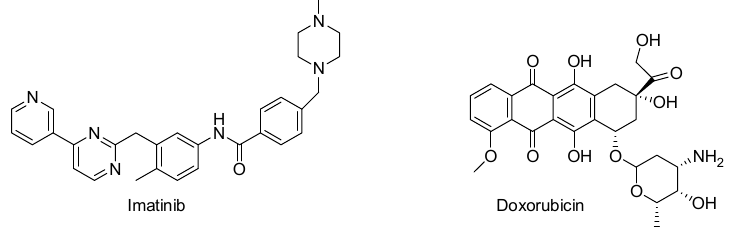
Figure 2. Structure of Imatinib and Doxorubicin.